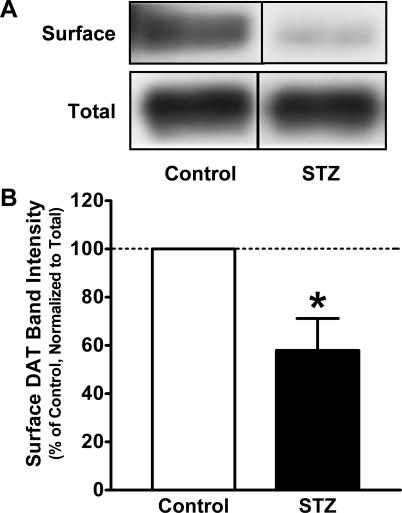
Cell Surface DAT Expression within Striatum Is Reduced in STZ-Treated Rats(A) Representative immunoblots for biotinylated (surface) and total DAT, in either untreated subjects (control) or in those that received streptozotocin (STZ). (B) Quantitation of DAT immunoreactivity from immunoblotting as in panel A conducted in striatal synaptosomes 7 d after STZ (65 mg/kg, i.v.). Biotinylated proteins (30 μg), representing 10% of the total lysate (300 μg protein) were separated by SDS-PAGE and underwent immunoblotting with a DAT-specific antibody; samples containing total lysates were run on adjacent lanes. Each biotinylated DAT band density was normalized to that of its corresponding total DAT band. Surface-to-total DAT ratios were then expressed as a percentage of control. *p < 0.05, Students t-test for independent samples (n = 3).